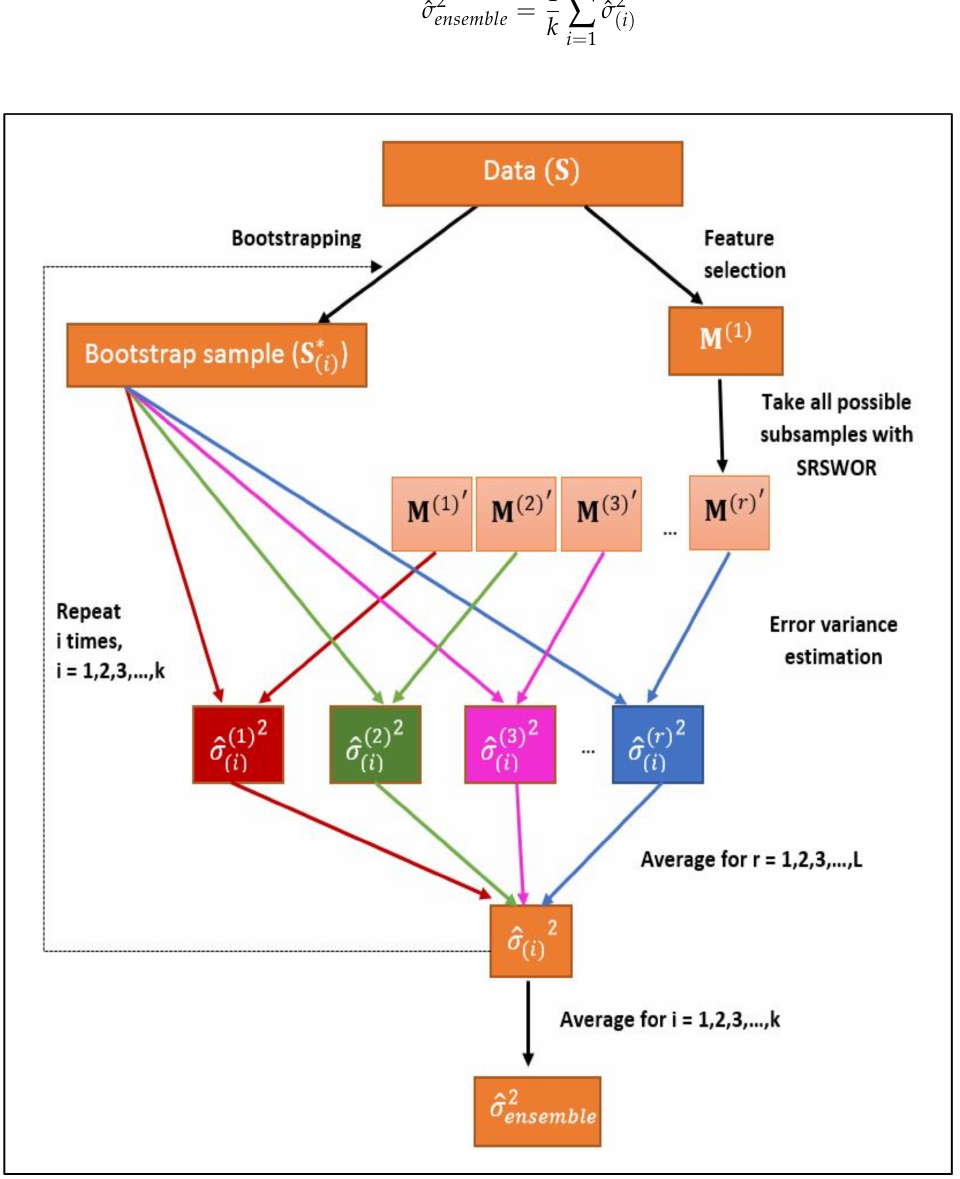
Figure 4. Ensemble method. Variables are selected with the help of three feature selection methods separately using SpAM, LASSO and Least Squares Regression models. Let error variance estimator of SpAM, LASSO and Least Squares Regression is represented by ˆ σ 2 In the above algorithm, ˆ σ 2